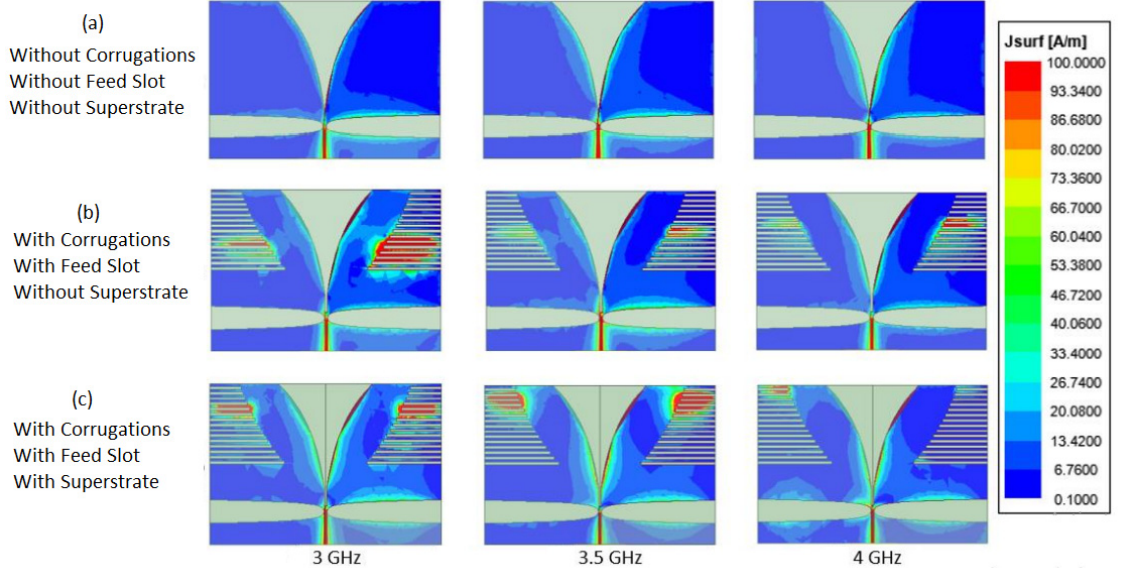
Figure 4. Surface current distribution on the proposed antenna 1 at 3 GHz, 3.5 GHz, and 4 GHz—( a ) without corrugations, feed slot, and superstrates; ( b ) with corrugations and feed slot and without superstrates; and ( c ) with corrugations, feed slot, and superstrates.